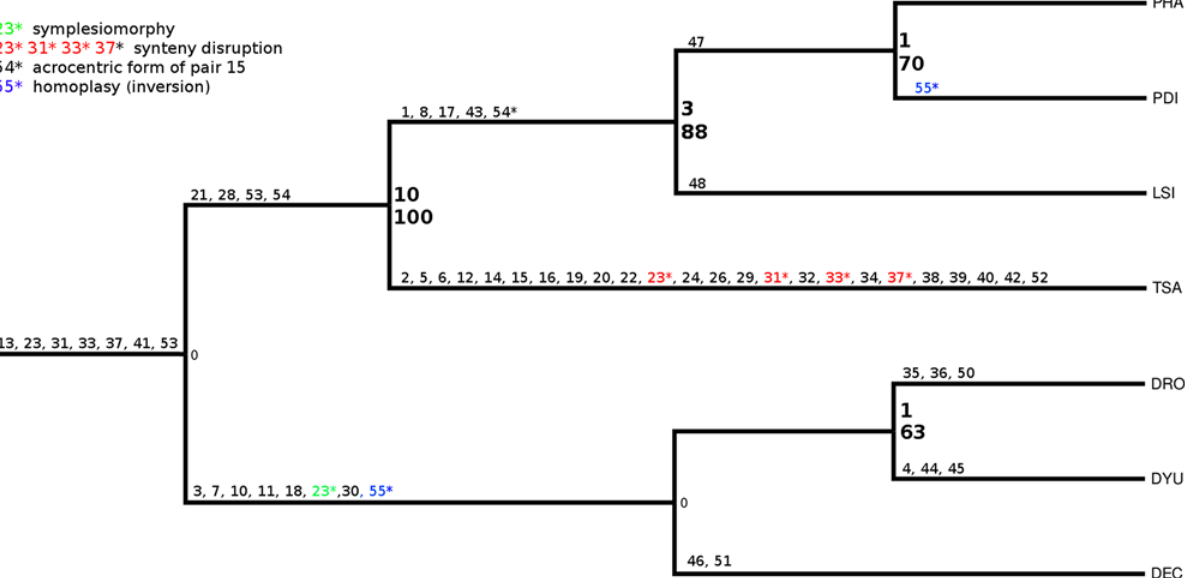
Fig 6. Cladogram obtained after the analysis by PAUP of the species PHA, PDI, LSI and TSA, using DEC, DYO, and DRO as outgroup using the chromosomal rearrangements as the unique caracters. Bold numbers indicate Bremer test (above) and bootstrap (below) values for each branch. The numbers refers to the chromosomal changes listed on the Basic Data Matrix (S1 Table). All the chromosomal changes (55) were mapped a posteriori , including 32 autapomorphies, 15 synapomorphies, 7 plesiomorphies and one